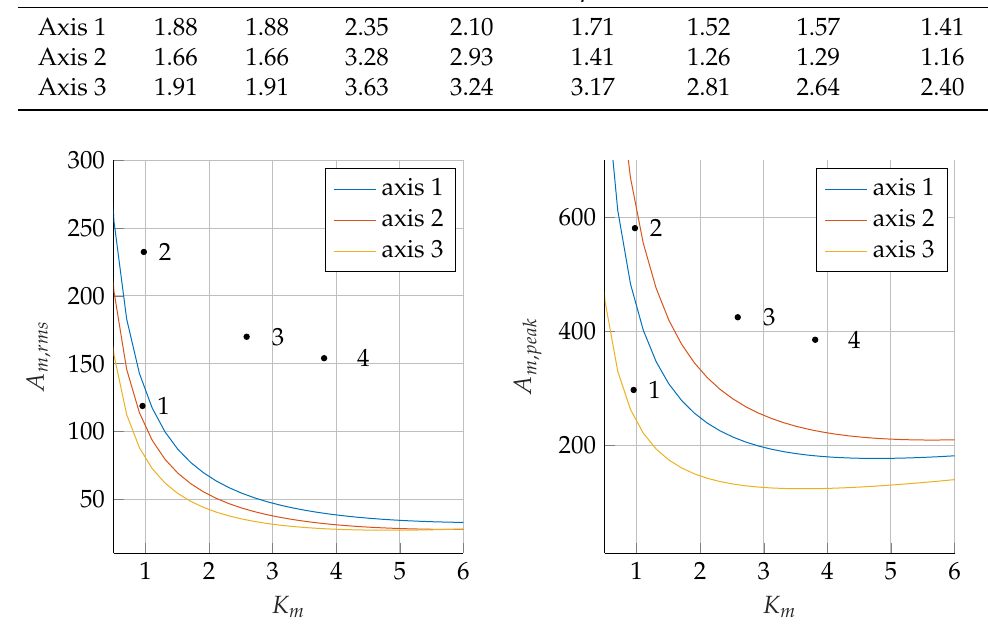
Figure 17. PDS points and load curves (one for each axis) at maximum payload for mixed load conditions. The left panel represents the A m , rms curves and the P pds , rated points of the candidate power drive systems; the right panel represents instead the A m , peak curves and the P pds , max